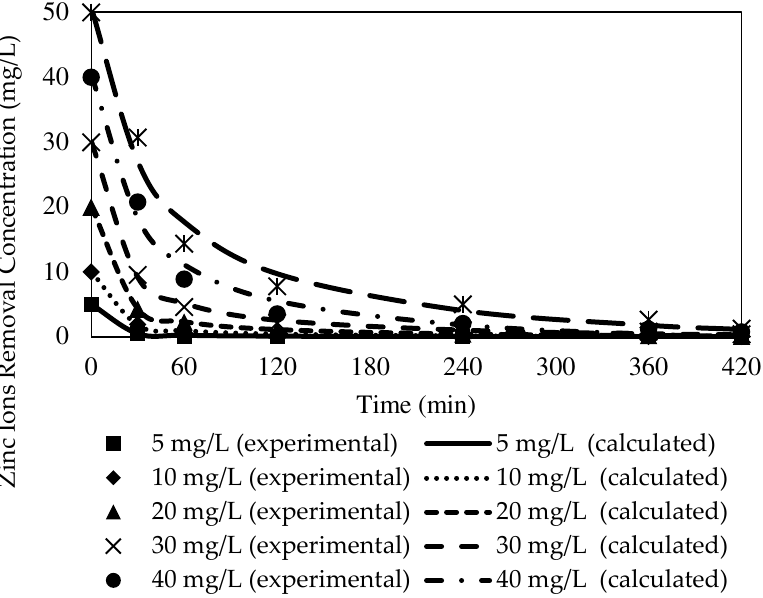
Figure 17. Fitting of the experimental data to the PSO model describing Zn 2+ removal by the W3 membrane over time at different initial source phase concentrations.